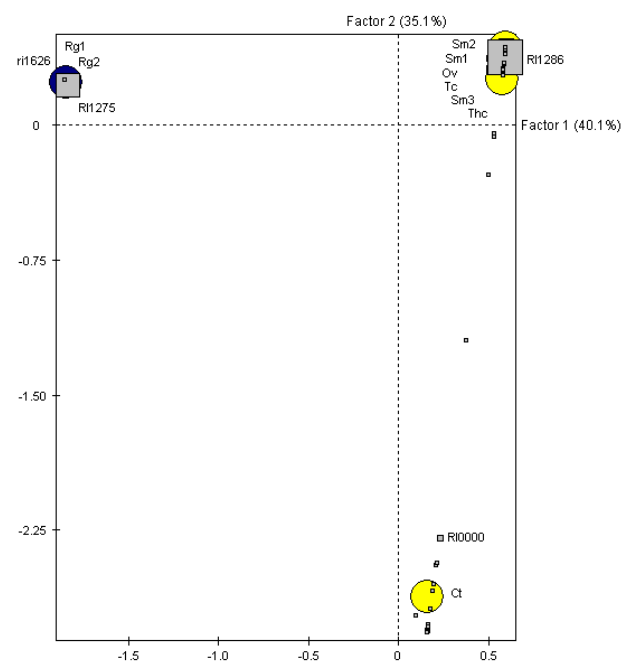
Figure 1. Ordination of essential oils (circles) and constituents (squares) in the first two factors of correspondences